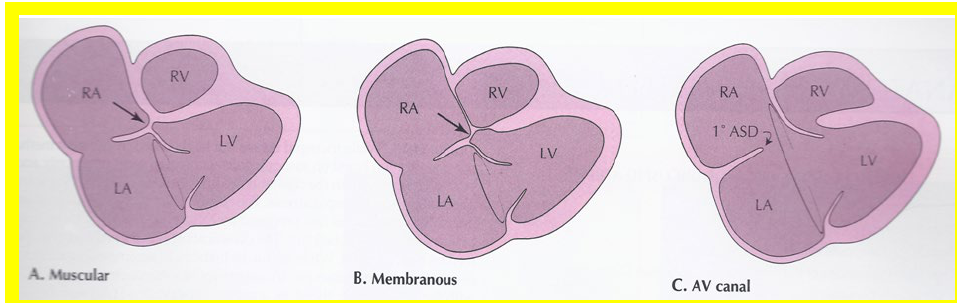
Figure 8. Line drawings demonstrating two dimensional echocardiographic appearances in a sub- costal four chamber view of the muscular ( A ), membranous ( B ), and atrioventricular canal ( C ) variants of tricuspid atresia. ( A ) The atretic tricuspid valve is represented by a thick band of echoes between the right atrium (RA) and the small right ventricle (RV) in the muscular type. ( B ) The tricuspid valve is represented by a thin line in the membranous type. Note that crux of the heart (arrows in ( A , B )) is clearly seen in both these types ( A , B ). The attachment of the anterior leaflet of the detectable atrioventricular valve to the left side of the interatrial septum is evident. ( C ) In the atrioventricular canal type of tricuspid atresia, the anterior leaflet of the detectable atrioventricular canal is attached to the anterior wall of the heart, occluding the right ventricle from the right atrium, and allows the exit of blood from both atria into the left ventricle (LV). The crux cordis and the atrioventricular portion of the interventricular septum are not seen. Reproduced from Rao PS. Brit Heart J 1987;58:409–412 [30] and from Reference [12].